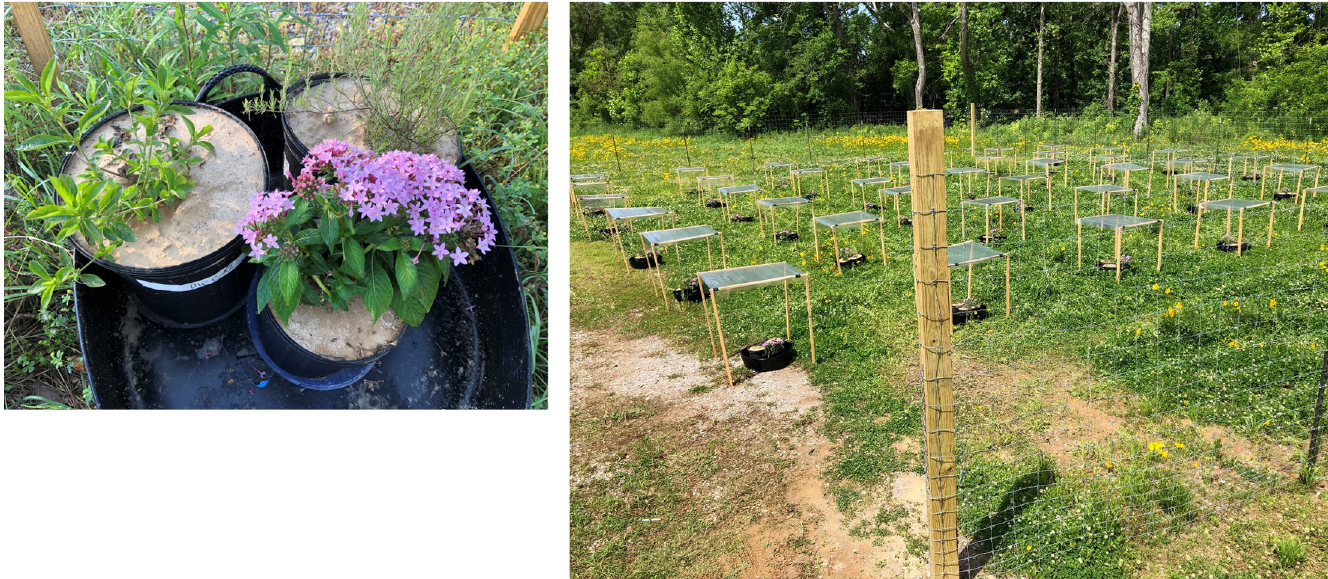
Fig 1. Images of outdoor plot at commencement of trial. Above , outdoor plot station with one potted plant per species for R . caroliniensis (left), C . canescens (upper right), and P . lanceolata (lower right). Right , outdoor experimental grid of 48 stations.